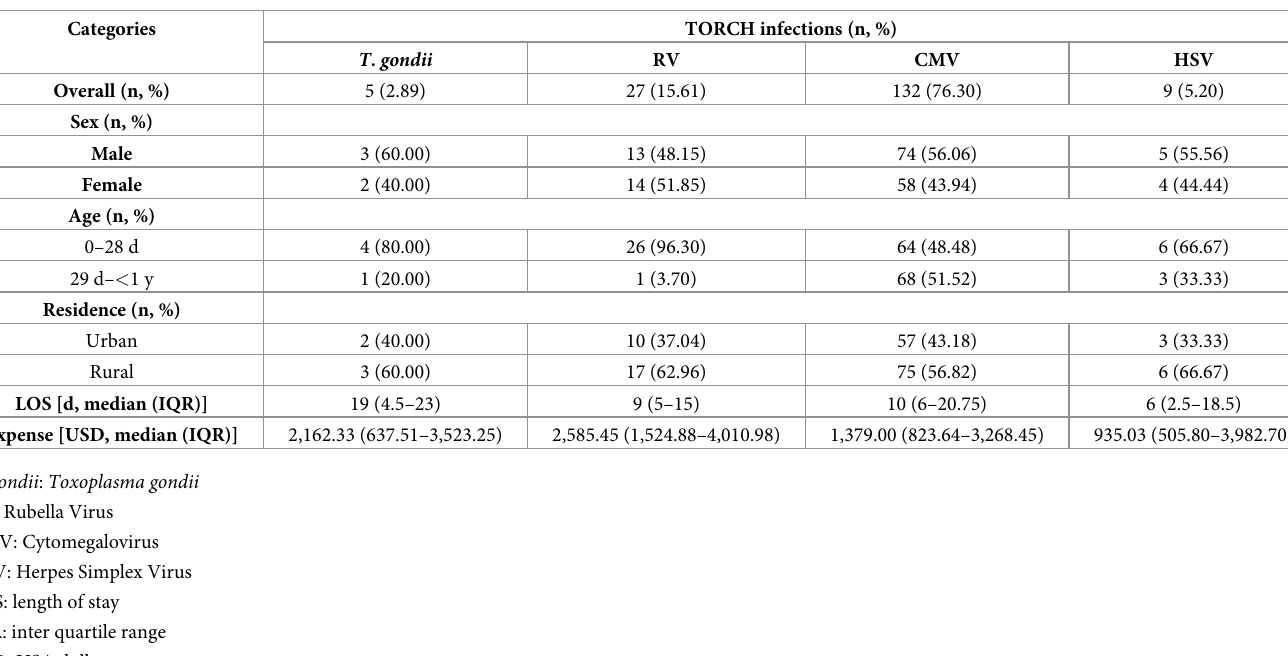
Table 1. The general sociodemographic characteristics of pediatric patients with TORCH infections during hospitalization from December 2015 to December